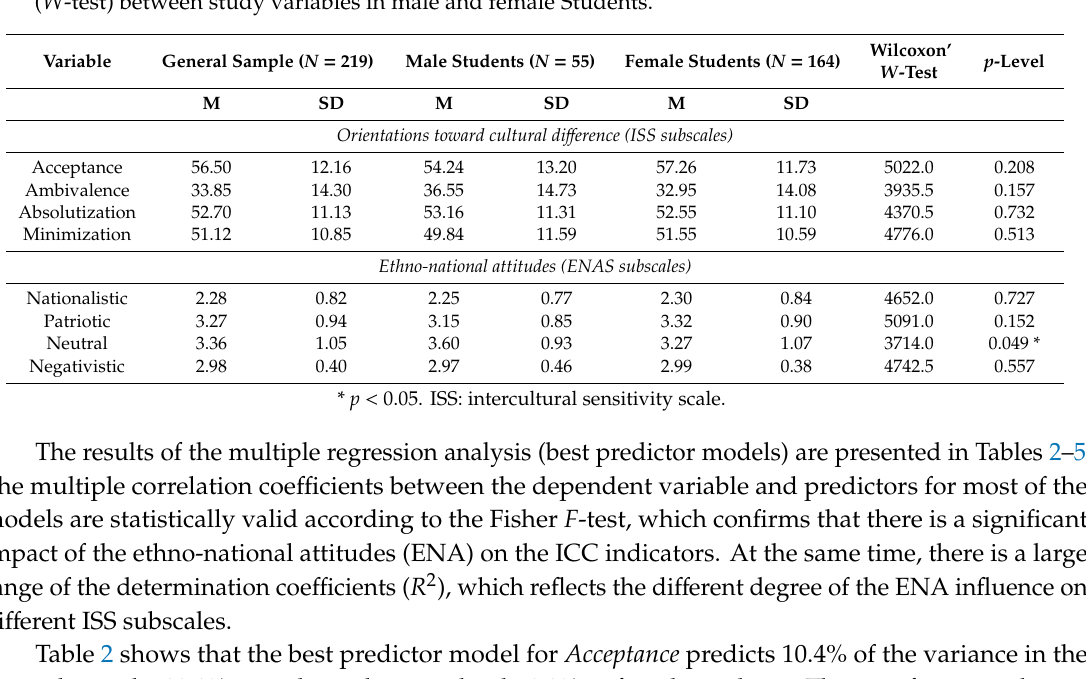
Table 1. Means (M), standard deviations (SD) and Wilcoxon rank sum test with continuity correction ( W -test) between study variables in male and female